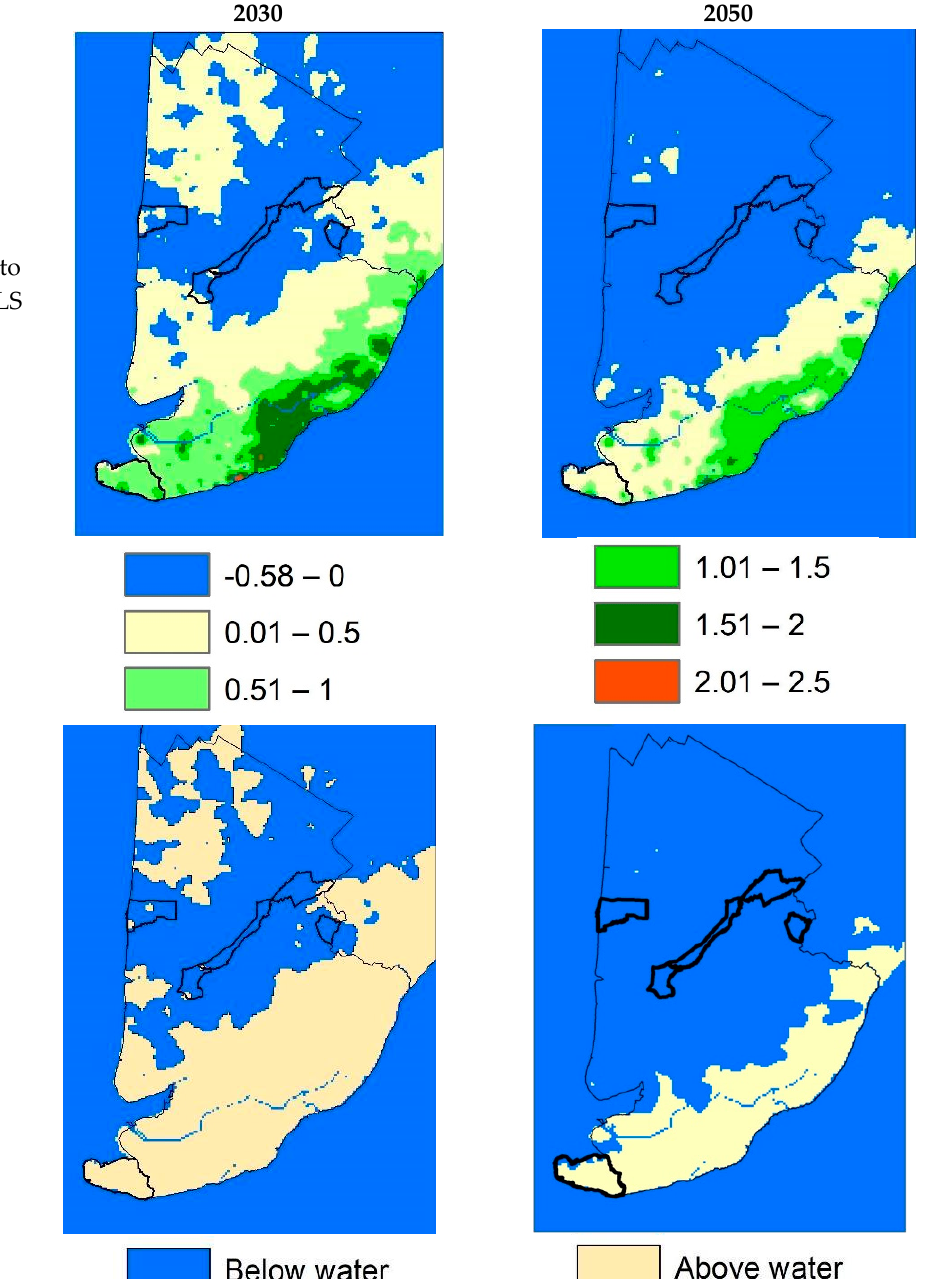
Figure 3. Ca Mau province elevation projections for 2030 and 2050, based on ( a ) land subsidence only; and ( b ) land at risk of submersion due to land subsidence and sea level rise at Mean Sea Level (MSL. Measurements are in meters in relation to sea level (Hon Dau 1992 datum).